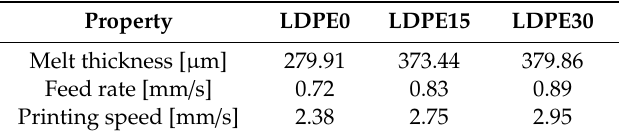
Table 7. Results of mathematical modeling: melt thickness, feed rate, and printing speed (Equations (7) and (8)).